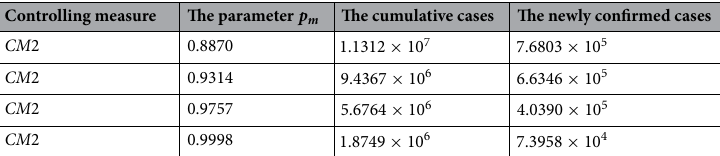
Table 10. The effect of the CM 2 on the cumulative cases.